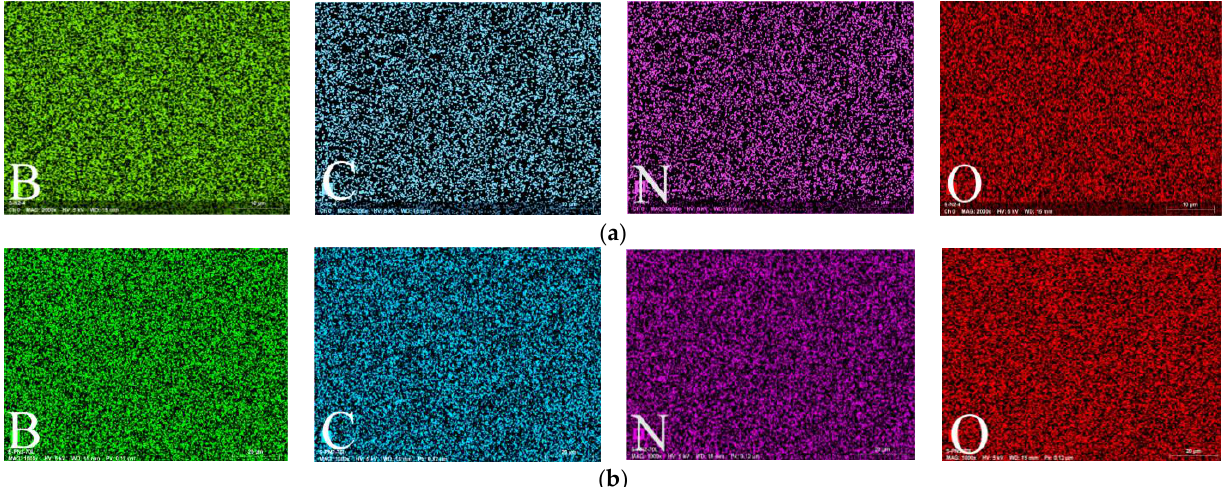
Figure 4. SEM-EDX elemental mapping of BC x N y films synthesized by ( a ) LPCVD and ( b ) PECVD methods from TMAB+N 2 mixture at 973 K and 373 K, respectively.